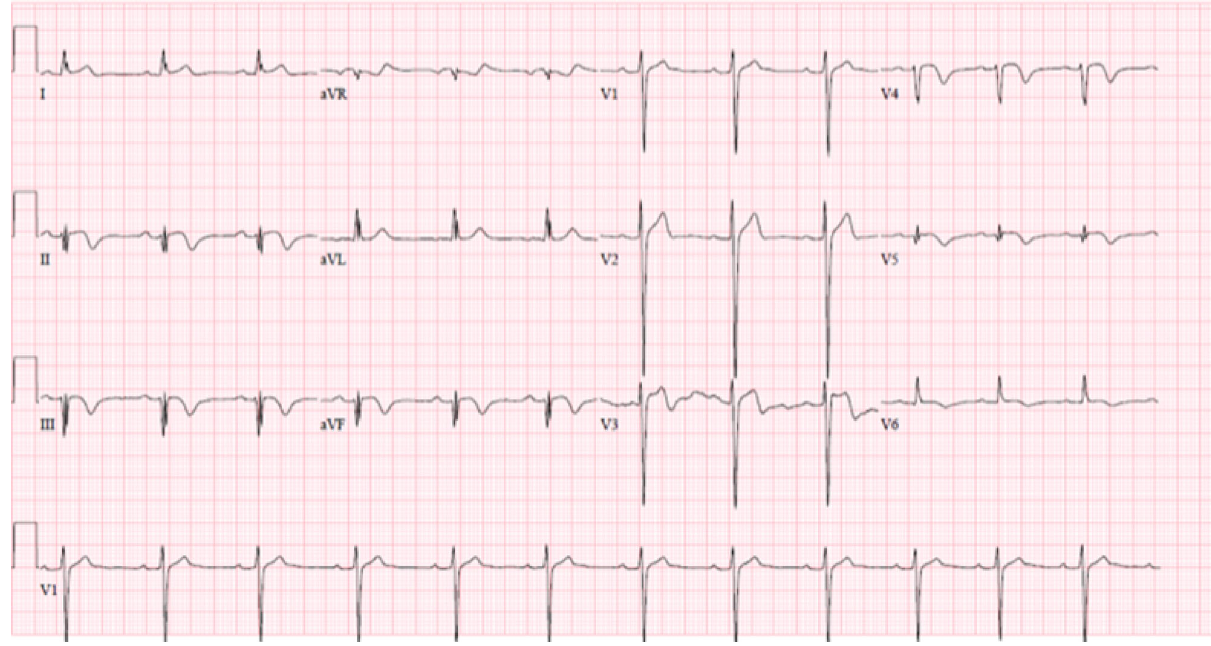
Figure 1: 12-lead ECG showing ischemic changes.